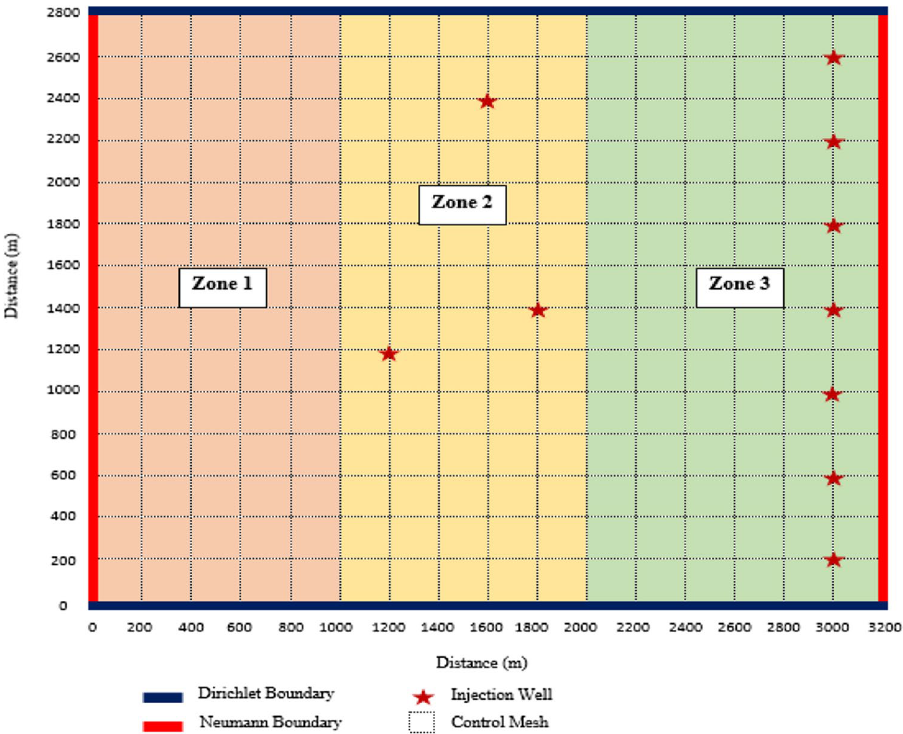
Fig. 7 Optimal location of injection wells under scenario 1